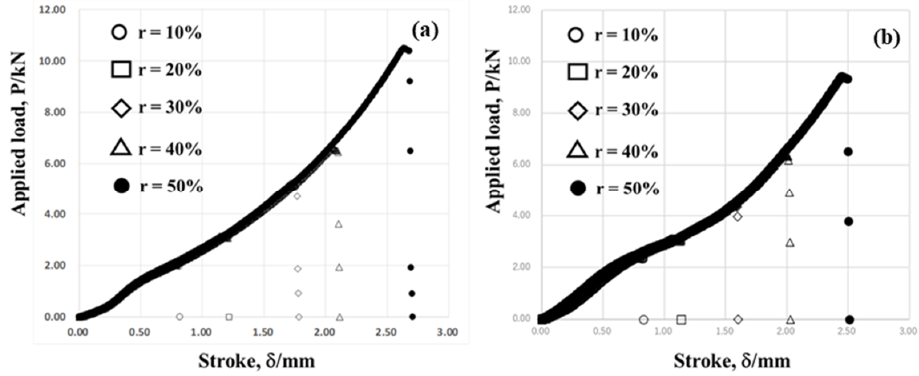
Figure 6. The load–stroke (P- δ ) relationship in upsetting the pure titanium and β -titanium wires down to the specified reduction in thickness (r) by using the Cs-SKD11 punch and the β -SiC-coated SiC die. ( a ) The P- δ relationship for upsetting the pure titanium wire, and ( b ) the P- δ relationship for upsetting the β -titanium